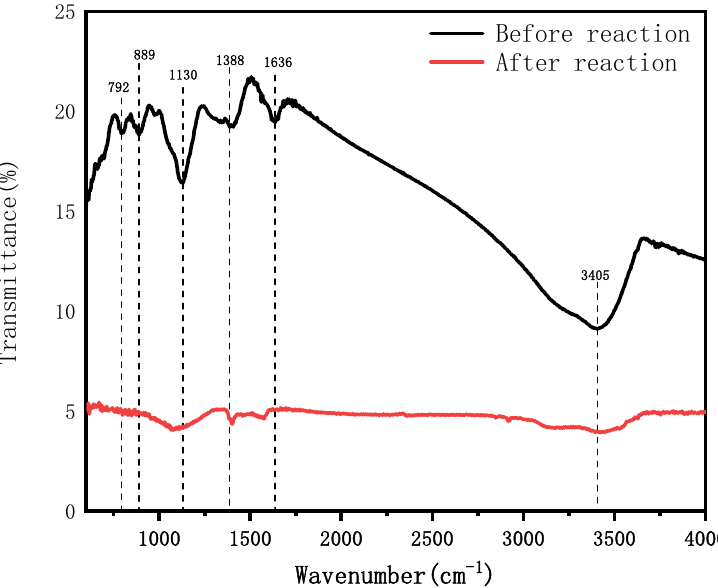
Figure 15. Infrared spectra of Co-nZVI/GAC activated PS before and after PNP degradation reac- tion.